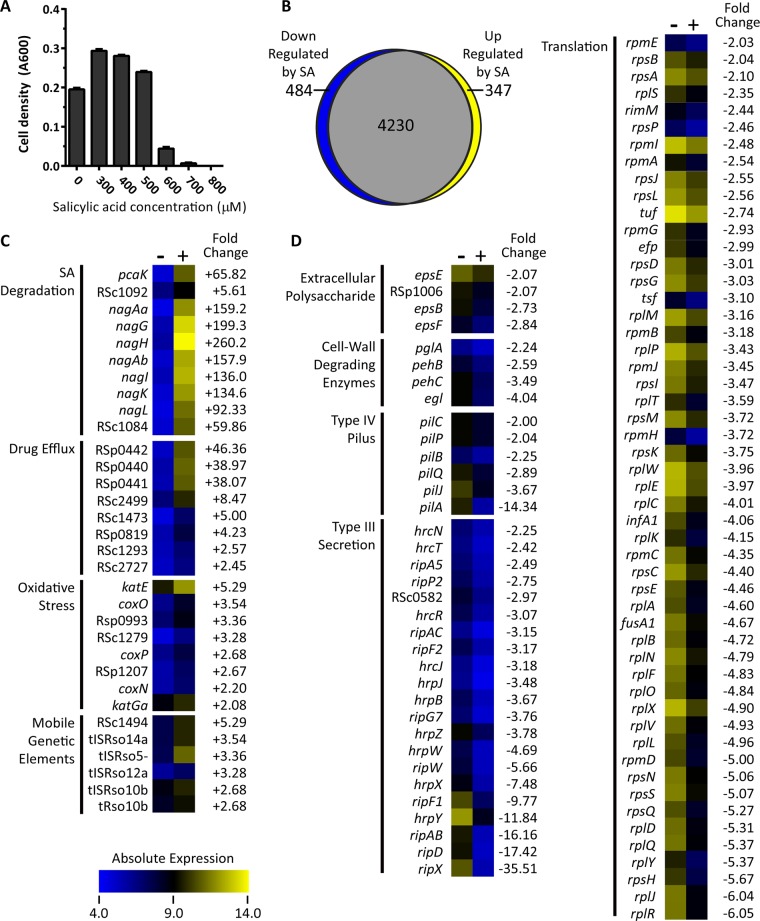
SA modulates R. solanacearum gene expression. (A) SA inhibits R. solanacearum growth. Strain GMI1000 was grown in minimal medium plus succinate with increasing SA concentration. Cell density was measured based on the A600 after 48 h. The averages of three biological replicates with standard errors are shown. (B) A proportional Venn diagram of expression patterns created using BioVenn (78). Gene expression was measured on a custom-designed R. solanacearum strain GMI1000 microarray chip as previously described (28). ORFs with relative expression levels in SA medium greater than 2-fold different and adjusted P values of <0.05 were classified as differentially expressed. (C and D) Heat maps show absolute expression of genes induced (C) and repressed (D) by SA. The gene class is listed to the left of the gene name/gene locus. Heat maps indicating low absolute expression (blue; 4.0) to high absolute expression (yellow; 14.0) are shown to the right of gene names. The fold change (0 µM SA versus 500 µM SA) is shown to the right of each heat map. Heat maps were generated in MeV (version 4.9; Dana-Farber Cancer Institute; http://www.tm4.org/mev.html).